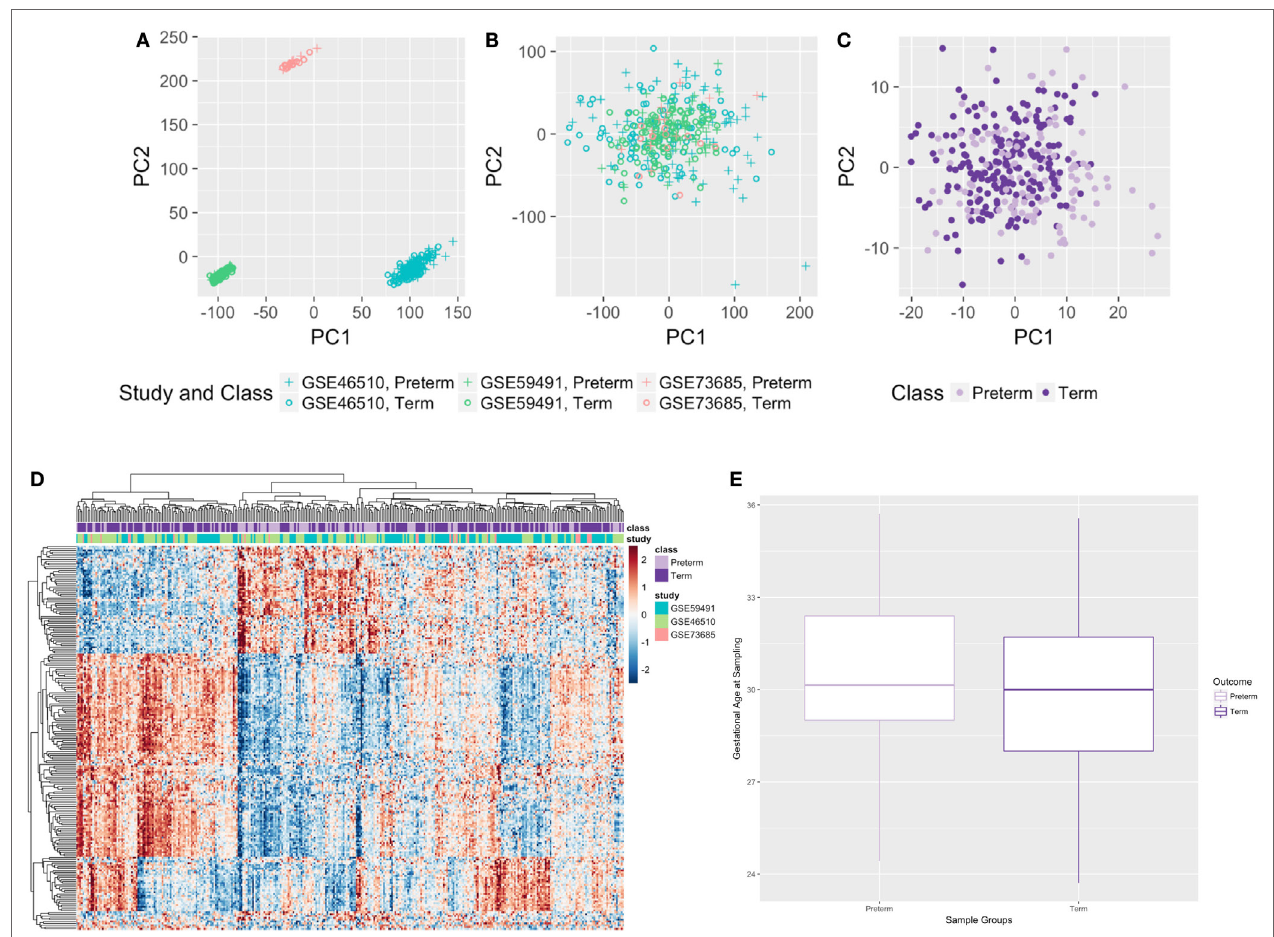
FiGURe 2 | Results from the cross-study meta-analysis and distribution of gestational age at sampling. (a,B) Principal component analysis plots with all genes before (a) and after (B) ComBat. (c,D) Principal component analysis plot (c) and heatmap (D) of all samples based on 210 significant differentially expressed genes. (e) Gestational age at sampling was not significantly different between preterm and term maternal whole blood samples ( n = 315, p -value =